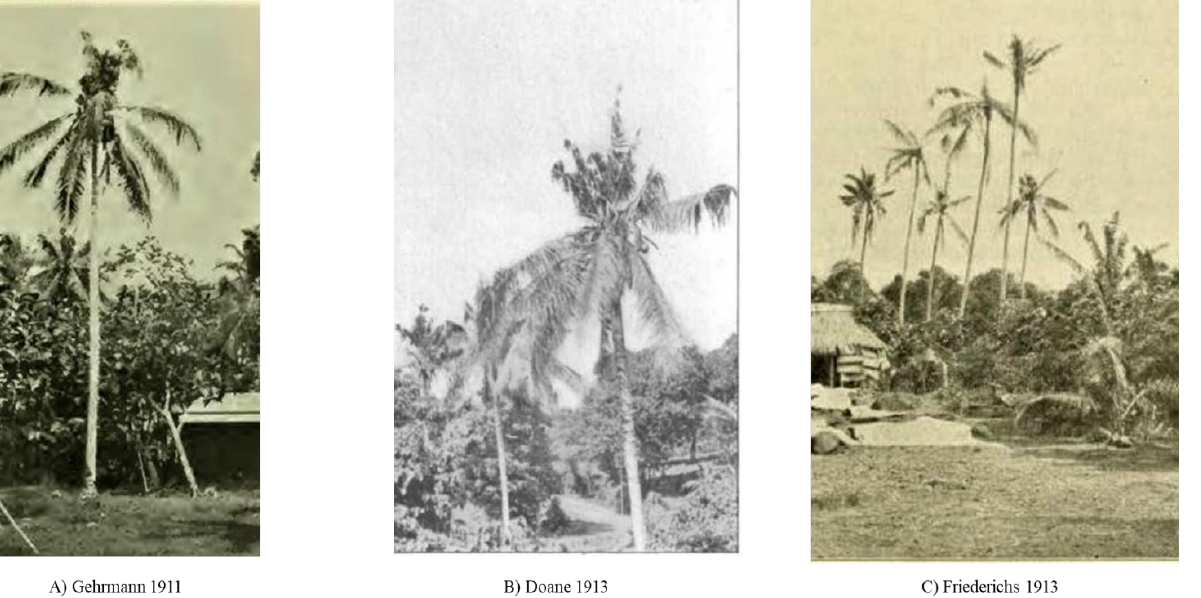
Figure 2. Photographs of damage recorded by early CRB researchers on